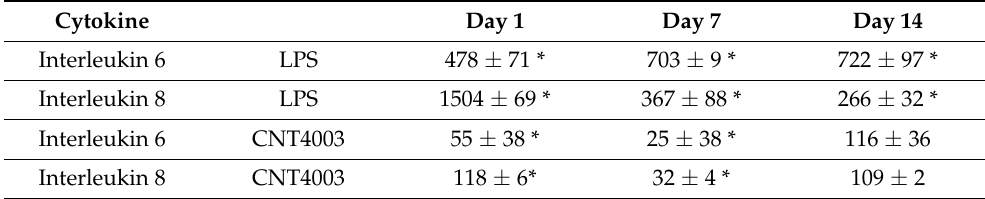
Table 1. Time-dependent changes (%) of cytokine secretion by Calu-3 upon stimulation with 10 µg LPS or 25 µg CNT4003. Secretion of unstimulated tissues is set as 100%. Significant differences ( p < 0.05) between treated and untreated samples are indicated by an asterisk.